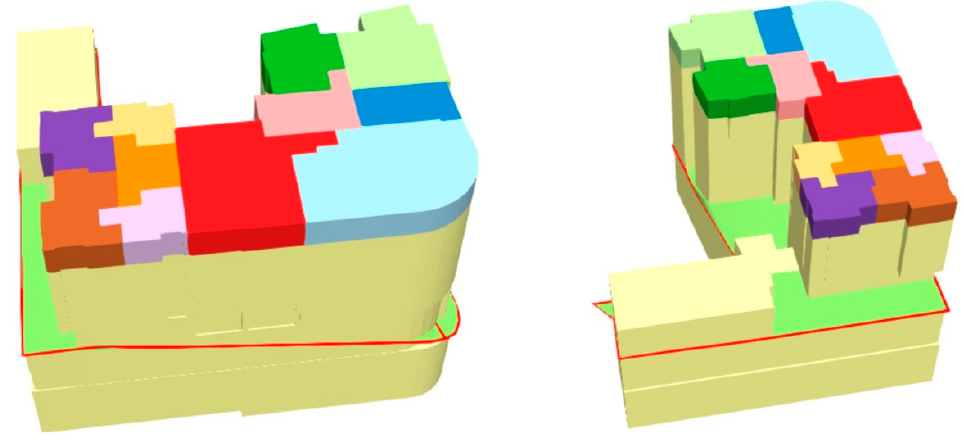
Figure 10. Visualization by using the floor mode.